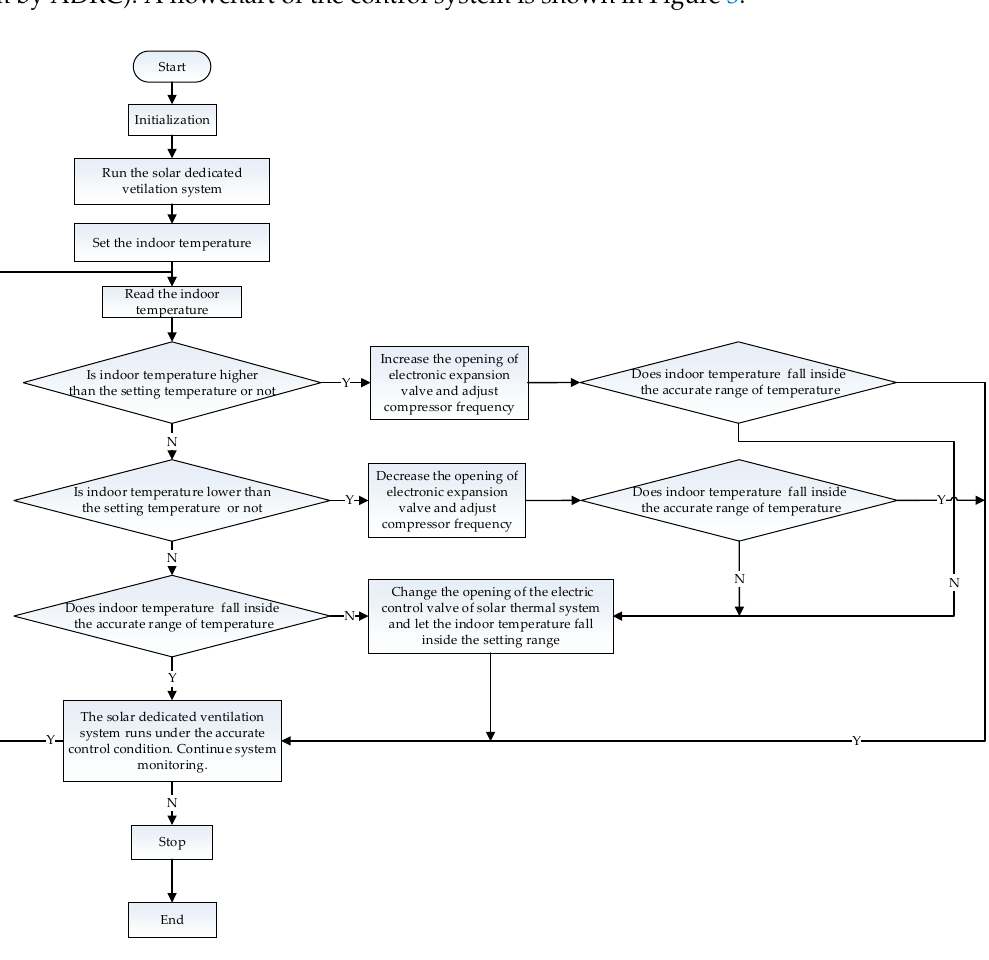
Figure 3. Flowchart of the control system.